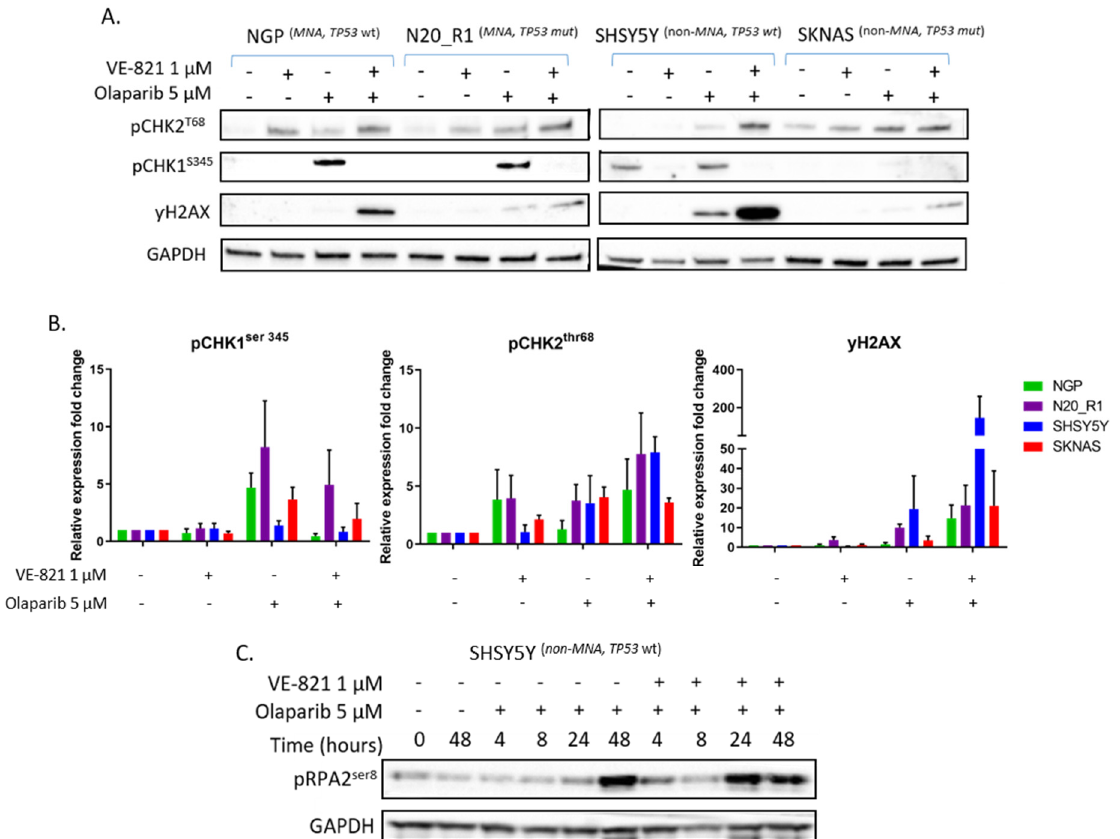
Figure 4. Effect of VE-821 and olaparib combination on replication stress. ( A ) pCHK1 S345 , pCHK2 T68 , γ H2AX protein expression of NGP, N20_R1, SHSY5Y and SKNAS cells after incubation with 5 μ M olaparib and/or 1 μ M VE-821 for 24 h. ( B ) pCHK1 S345 , pCHK2 T68 , γ H2AX mean fold change in protein band intensity measured by densitometry (ImageJ) and normalised to glyceraldehyde 3-phosphate dehydrogenase (GAPDH) loading control, data are mean + SEM from 3 independent experiments. ( C ) pRPA2 S8 expression in SHSY5Y cell line in response to 5 μ M olaparib with or without 1 μ M VE-821 over 48 h. Images of the uncropped Western blots can be found in Figure S8.